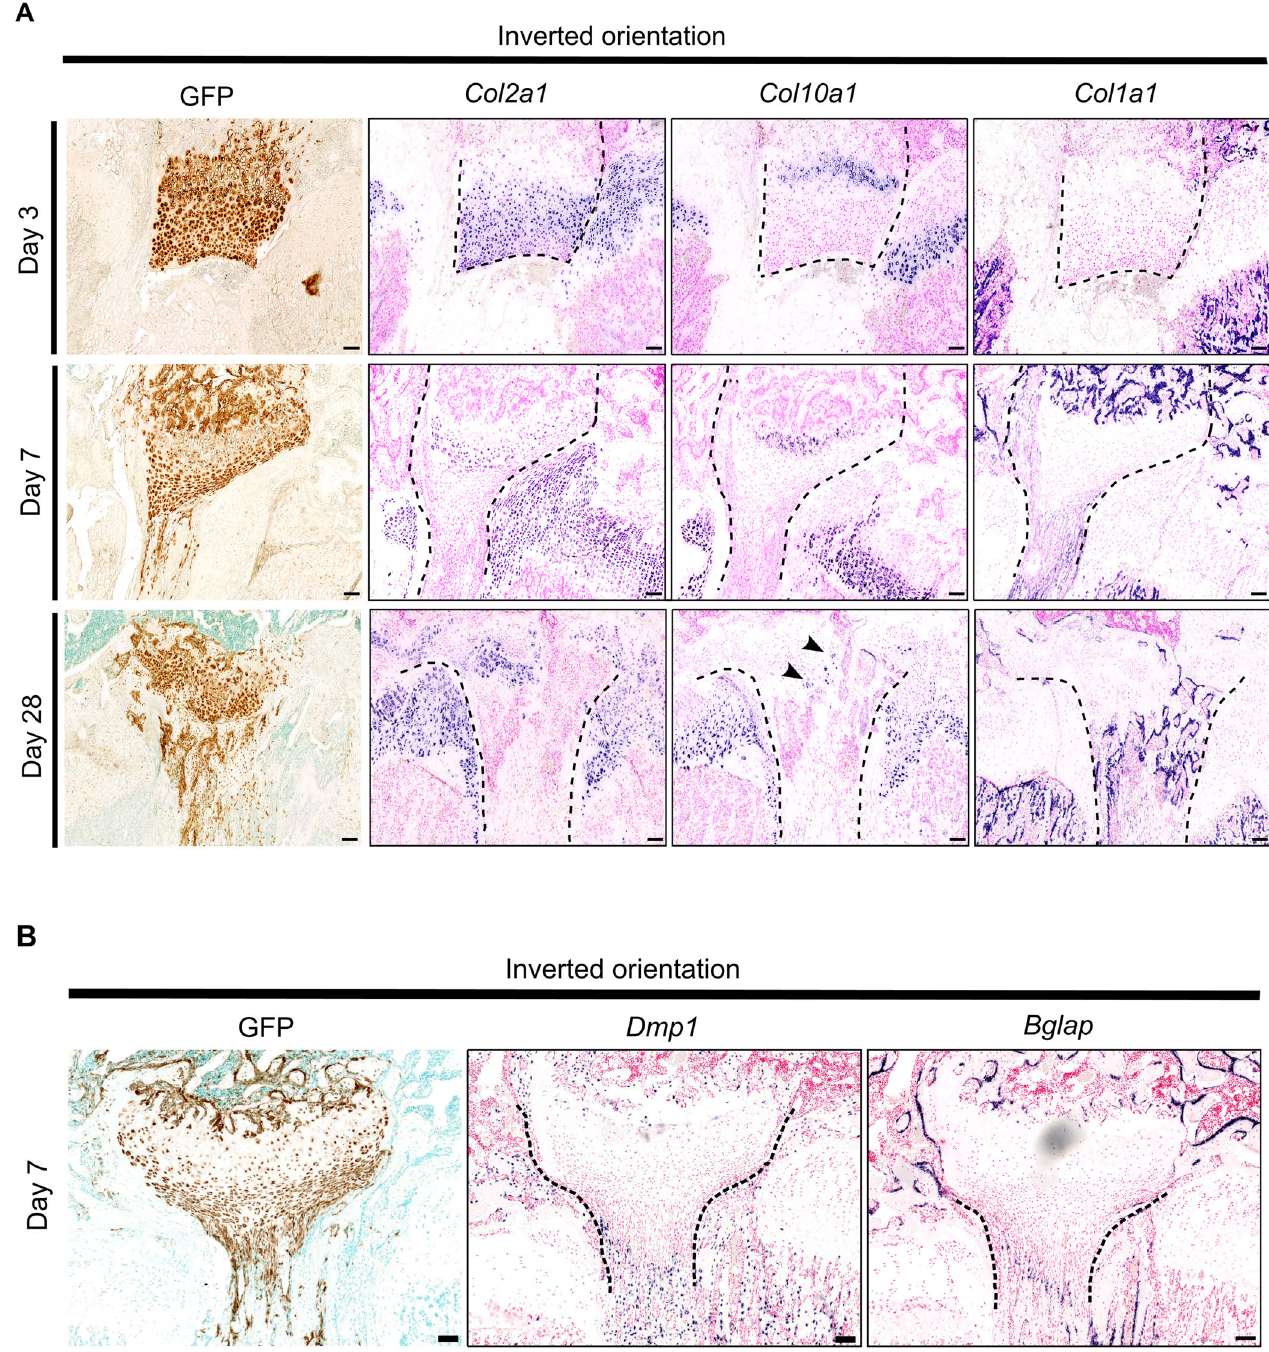
Fig. 7 Tracing and differentiation of articular cartilage chondrocytes inserted ectopically at the level of the growth plate. Transplanted cells and their derivatives were localized by GFP immunohistochemistry staining (brown coloration) on sections of recipient distal femurs at postoperative day 3, 7, and 28 ( A ) and day 7 ( B ). Differentiation of transplanted chondrocytes was assessed by Col2a1, Col1a1, Col10a1, Prg4 ( A ) as well as Dmp1 and Bglap ( B ) in situ hybridizations (purple coloration) on consecutive sections. The microphotographs display the articular cartilage side of the transplants that had been ectopically placed at the location of the growth plate (AC fl ip). Dashed lines delineate allografts, based on localization by GFP immunohistochemistry. Scale bar: 100 μ con fi rmed using a rat chondrocyte pellet culture model. Our other end in original or inverted orientation into distal femoral results taken together suggest that a factor or several factors in epiphyses of 4-week-old rats. Our model allowed the tracing and the synovial joint microenvironment are able to inhibit hyper- characterization of transplanted cells. We found that growth plate trophic differentiation and promote differentiation towards the cartilage transplanted to the articular surface remodeled into super fi cial articular chondrocyte phenotype. This novel mechan- articular-like cartilage and that hypertrophic differentiation was ism and the future identi fi cation of the putative factor(s) may have inhibited at the articular surface. These observations were